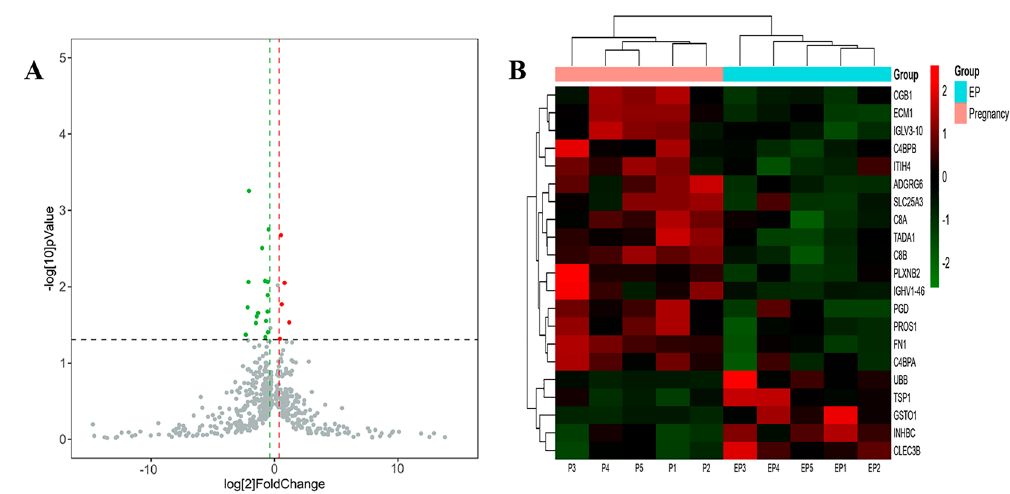
Figure 1. Volcano plot ( A ) and Cluster heatmap ( B ) of the differentially expressed proteins between IP and EP